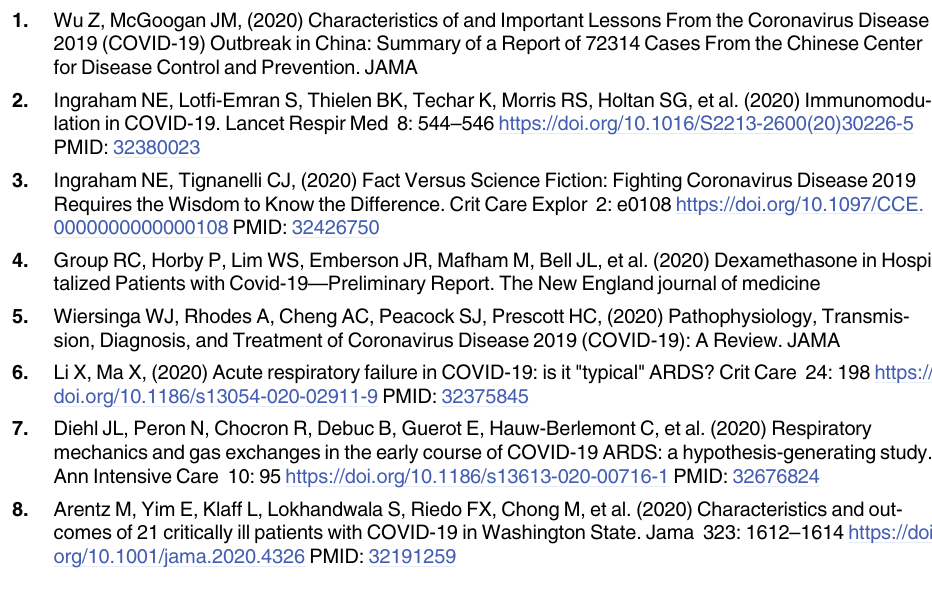
S5 Table. Home medications and hospital day 5 laboratory values of hospitalized COVID- 19 patients with clinical phenotypes I, II, and